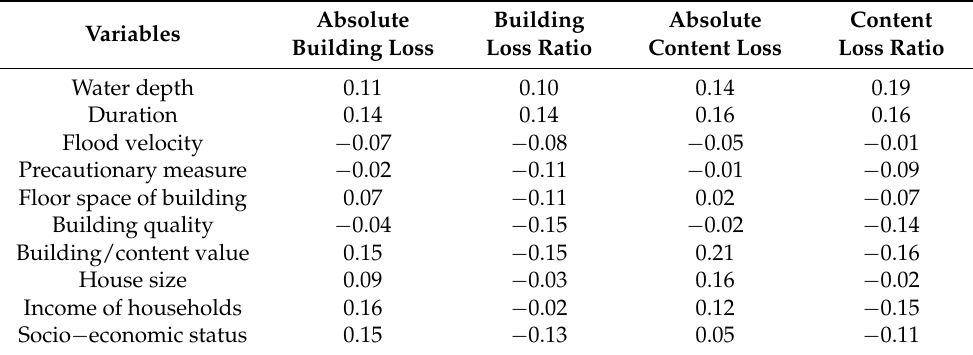
Table 8. The Pearson correlation coefficient of variables significantly correlated with absolute building loss, absolute content loss, building loss ratio and content loss